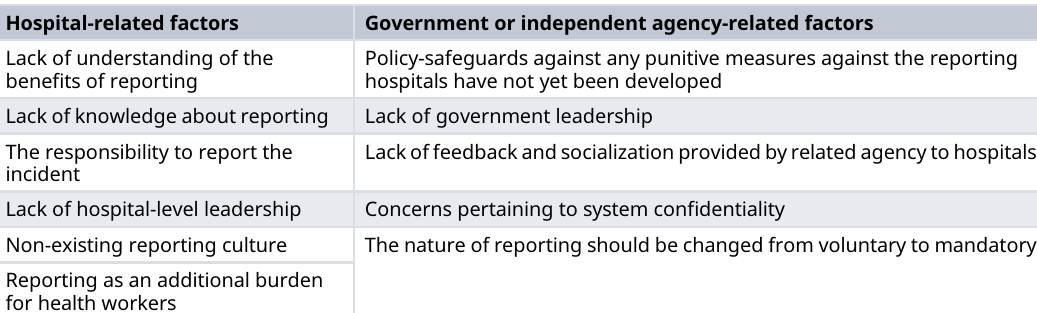
Table 3. Categorization of the causes of